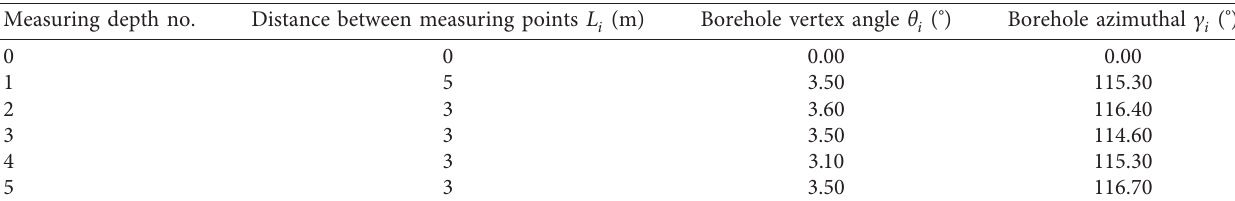
Table 2: Original incline-measure data table of an underground geological borehole. Measuring depth